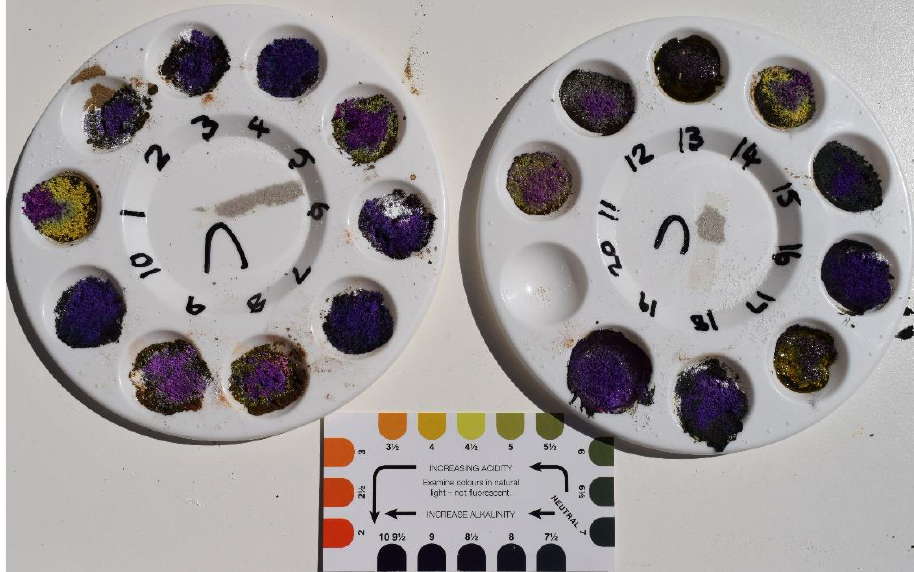
Figure 1. Example of soil pH colour indicator card and sample pot for field pH determination.